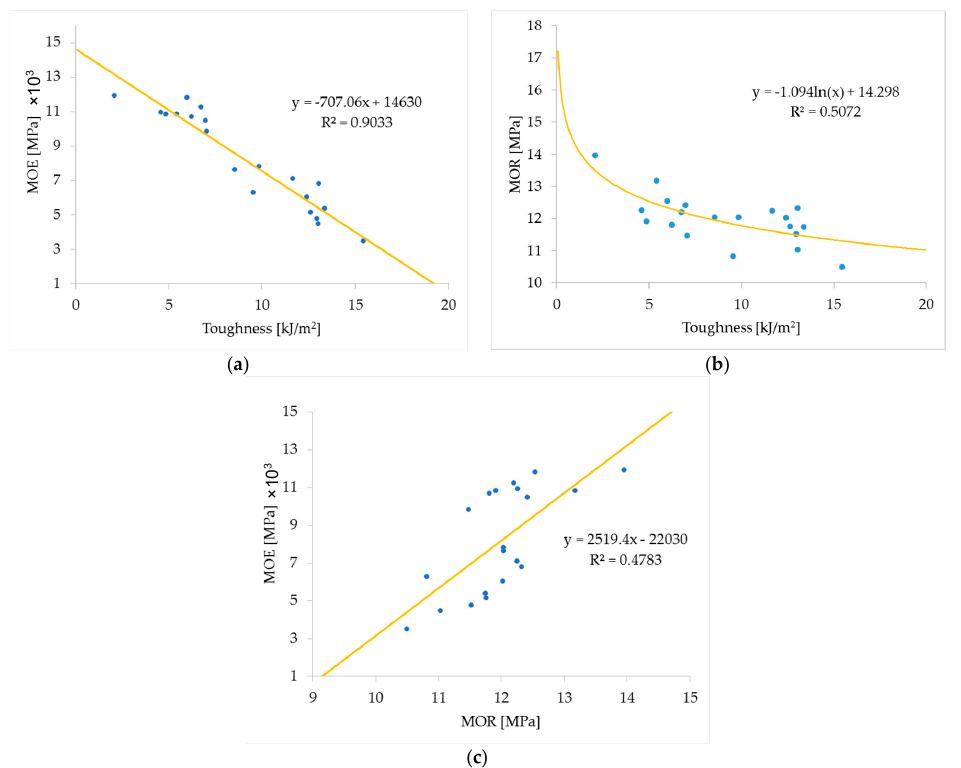
Figure 11. Relationship between modulus of elasticity (MOE), modulus of rupture (MOR), and toughness: MOE vs. toughness ( a ); MOR vs. toughness ( b ); MOE vs. MOR ( c ).